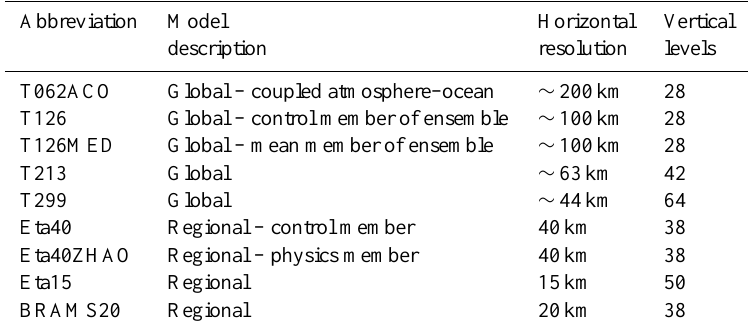
Table 1. Principal characteristics of the models